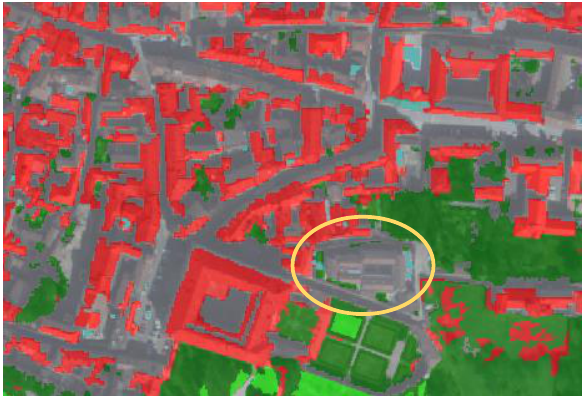
Figure 16. Same area after the classification with Random trees algorithm with an example of incorrect classification.